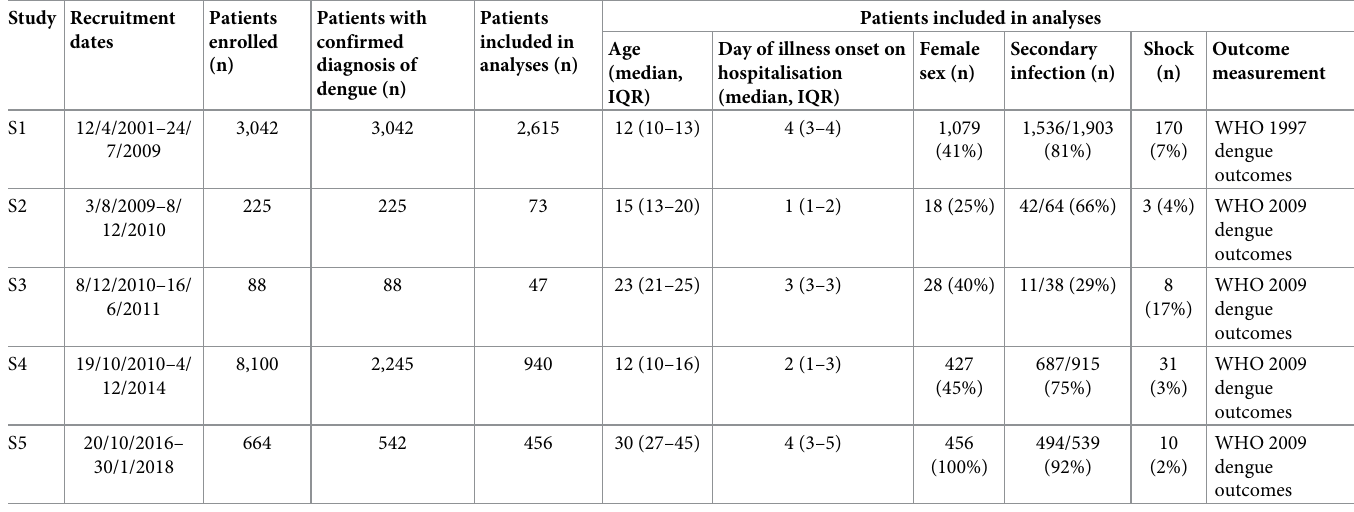
Table 1. Baseline characteristics of individual studies included in the final